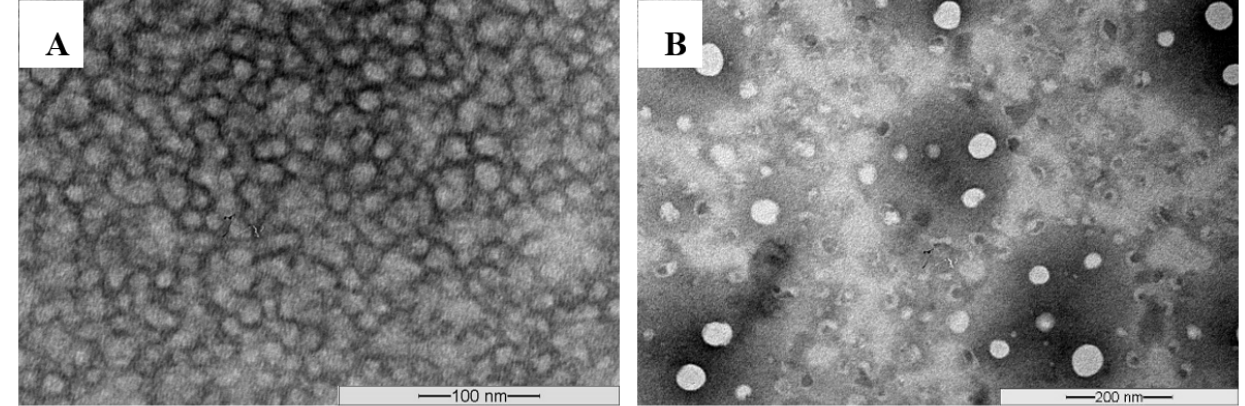
Figure 8. Representative TEM images obtained from unloaded Myrj S100- b -PCL 88 ( A ) and CyA- loaded Myrj S100- b -PCL 88 micelles ( B ) using JEOL JEM-1100 Transmission electron microscope (JA- PAN) operating at an acceleration voltage of 80